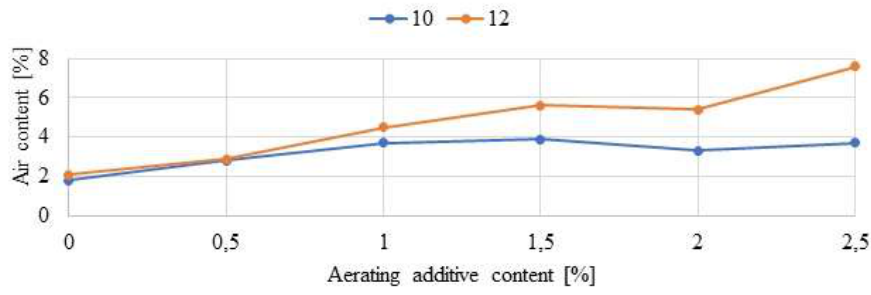
Figure 5. Series no. 10, 12 - Dependence of the amount of aerating additive on air